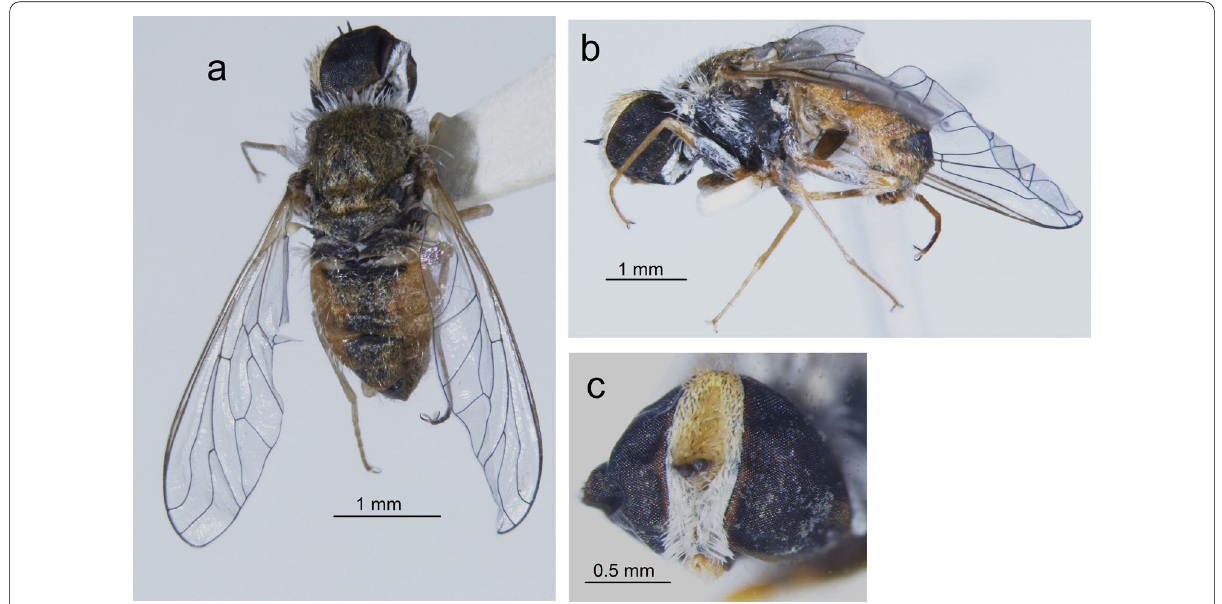
Fig. 5 Desmatoneura brevipennis (Bezzi). a Female habitus, dorsal view. b Same, lateral view. c head, frontal